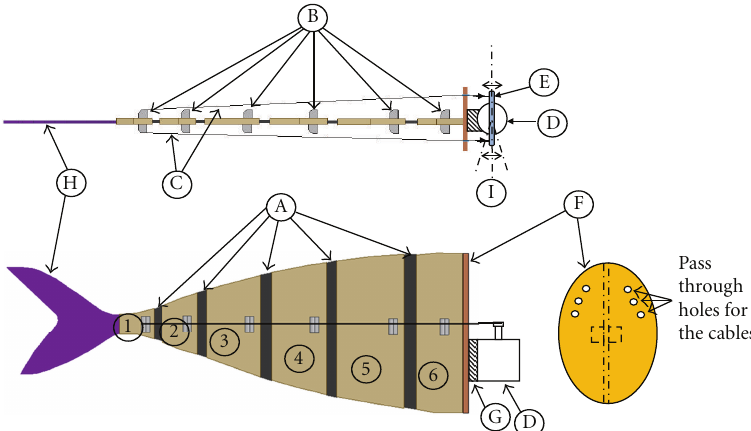
Figure 5: CAD model of the hydrostatic joints (of the tail) showing cables connected to the first segment